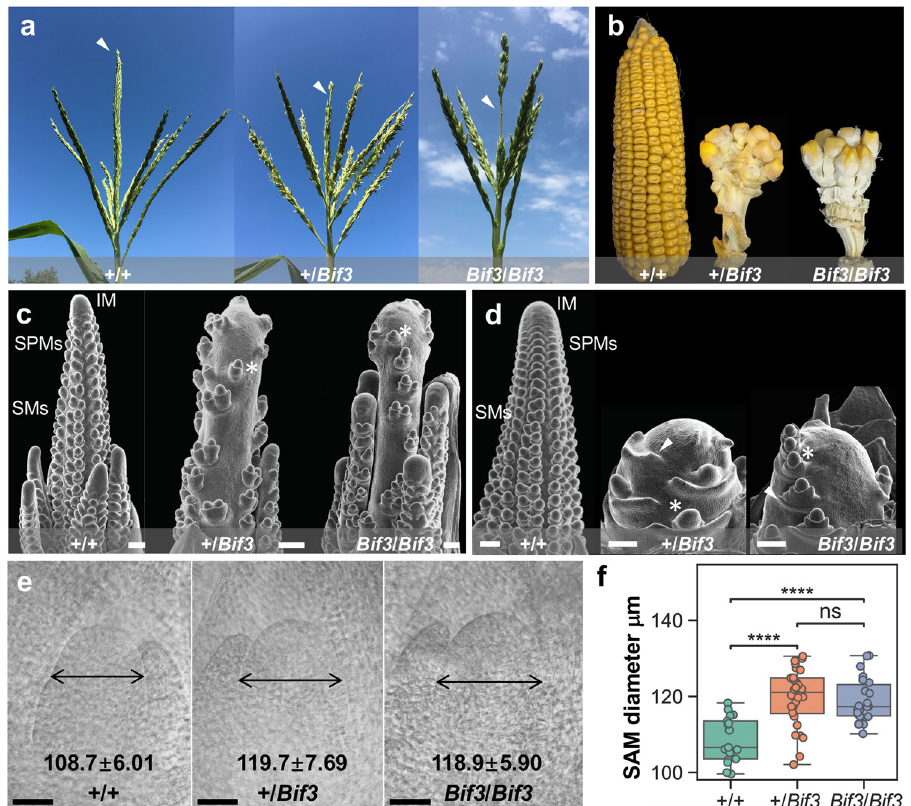
Fig. 1 Bif3 mutant phenotypes. a Normal tassels produce spikelets on branches and central spikes (white arrowheads). Barren patches are observed in Bif3 mutants. b Ball-shaped ear of Bif3 mutants. c , d SEM images of wild-type and Bif3 tassel, and ear primordia. Bif3 mutants show enlarged IMs, a reduced number of SPMs, single SMs (asterisks) and enlarged suppressed bracts (arrowheads). e Cleared shoot apical meristems (SAMs) from wild-type (A619), heterozygous, and homozygous Bif3 plants. The Bif3 SAMs have larger diameter (double-headed arrows). f Quanti fi cation of SAM diameter: two-tailed Student ’ s t -test, **** p < 0.0001 ( n + / + = 17; n + /Bif3 = 28; n Bif3/Bif3 = 22). Box plot center line, median; box limits, upper and lower quartiles; whiskers, maximum and minimum values. Scale bars: 200 μ m in ( c and d ); 50 μ m in ( e